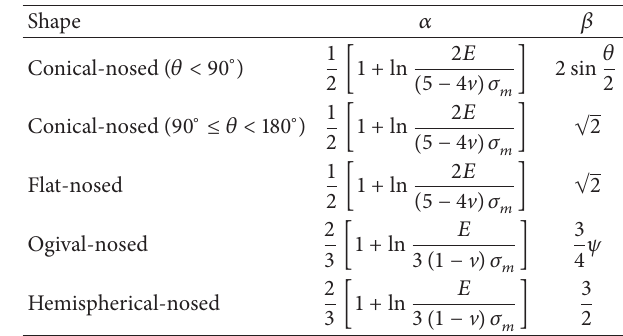
Table 3: Values of various parameters for concrete targets